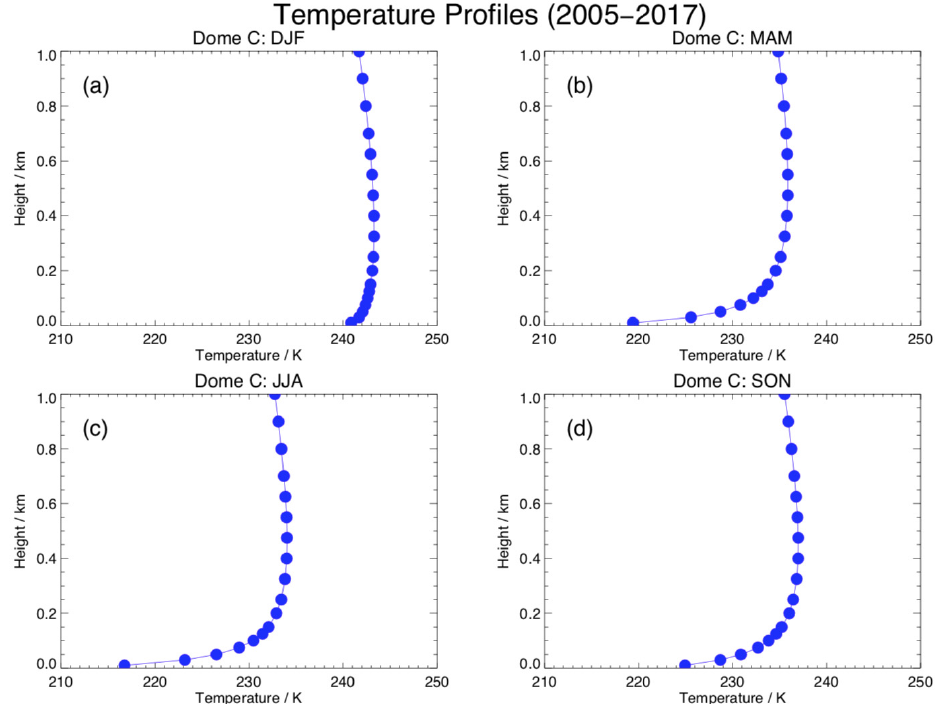
Figure 6. Mean profile of temperature from radiosondes at Dome C, over the period 2005–2017 in ( a ) DJF; ( b ) MAM; ( c ) JJA; and ( d ) SON.